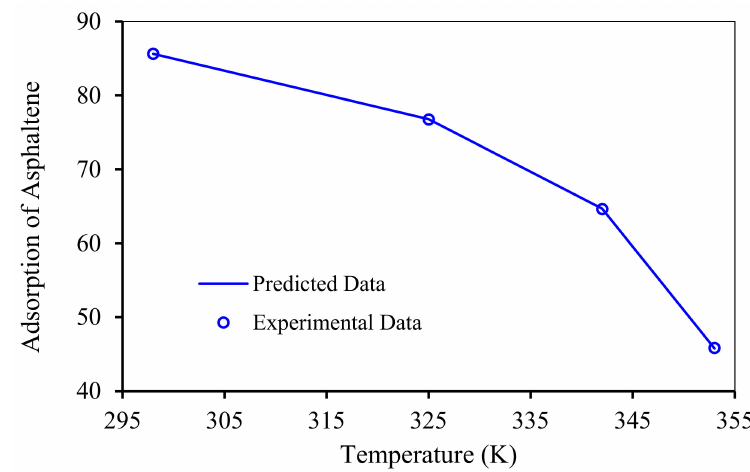
Figure 13. Experimental and predicted data by the RBF-ACO model for adsorption of asphaltenes by NiO / ZSM-5 at di ff erent temperatures and a pH of